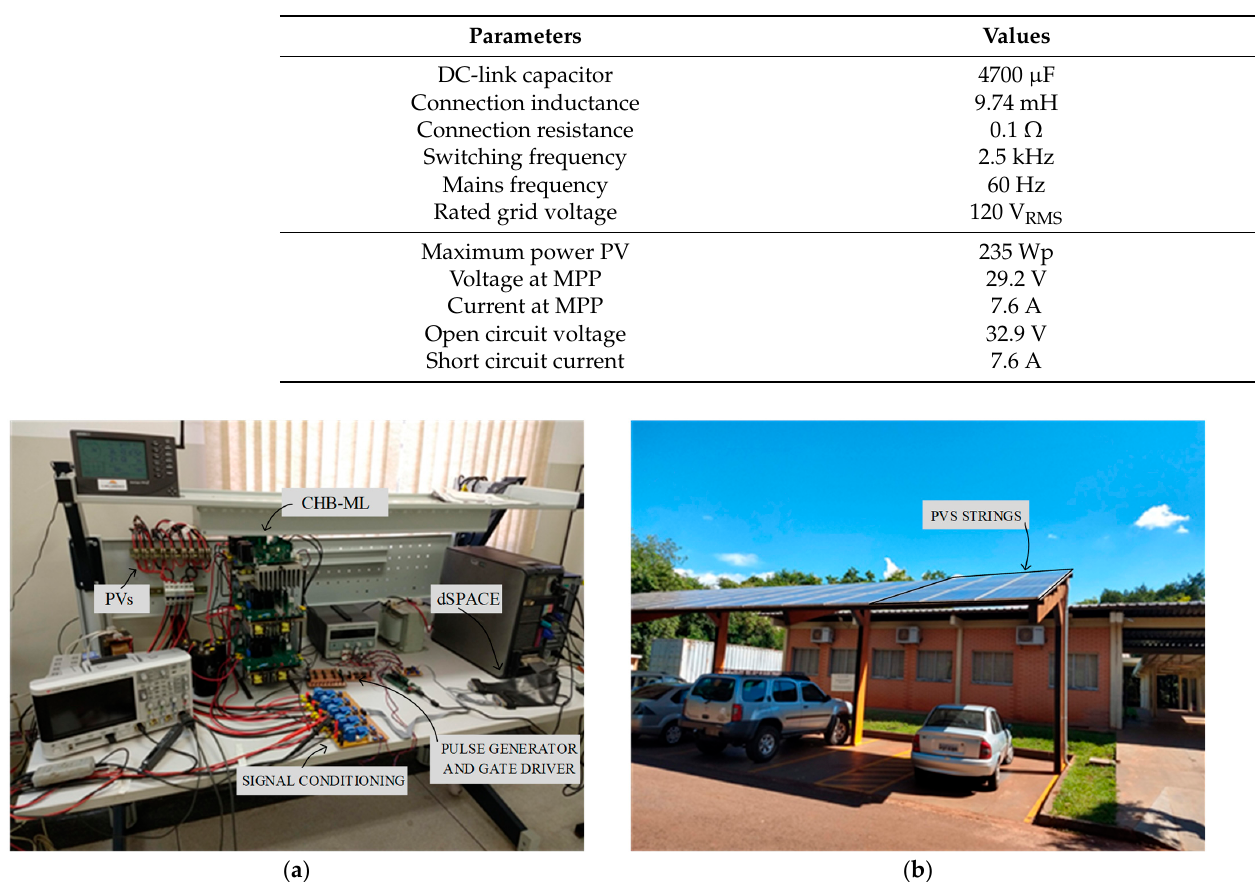
Figure 8. ( a ) Experimental setup for the seven levels cascaded H-bridge inverter; ( b ) Photovoltaic panels: Sun Earth PV-Module 235 W.